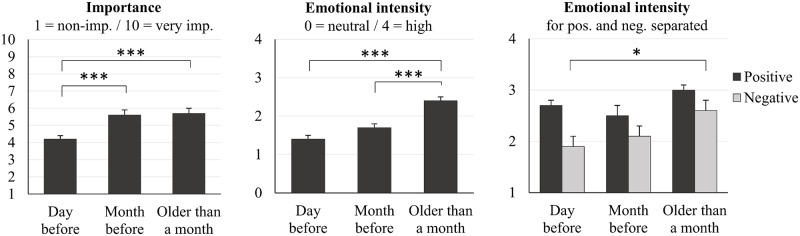
Emotionality of the dated WLEs incorporated into dreams as a function of their remoteness.(A) Importance scores of the WLEs incorporated into dreams as function of their remoteness. (B) Emotional intensity as a function of remoteness. (C) Emotional tone as a function of remoteness. Error bars represent standard error of the mean. *p<.05—**p<.01—***p<.001.